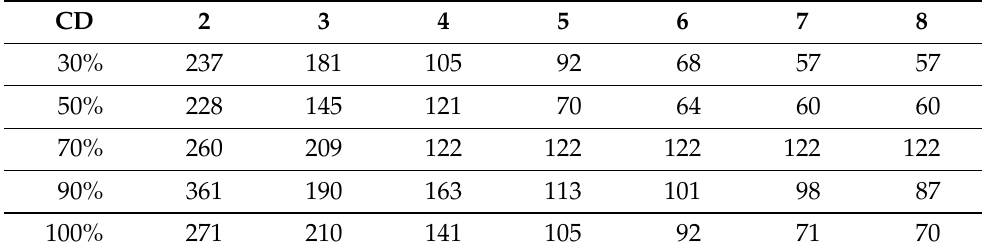
Table 3. AV 20 worst-failure case value varying the number of IEDs in (2, 8).